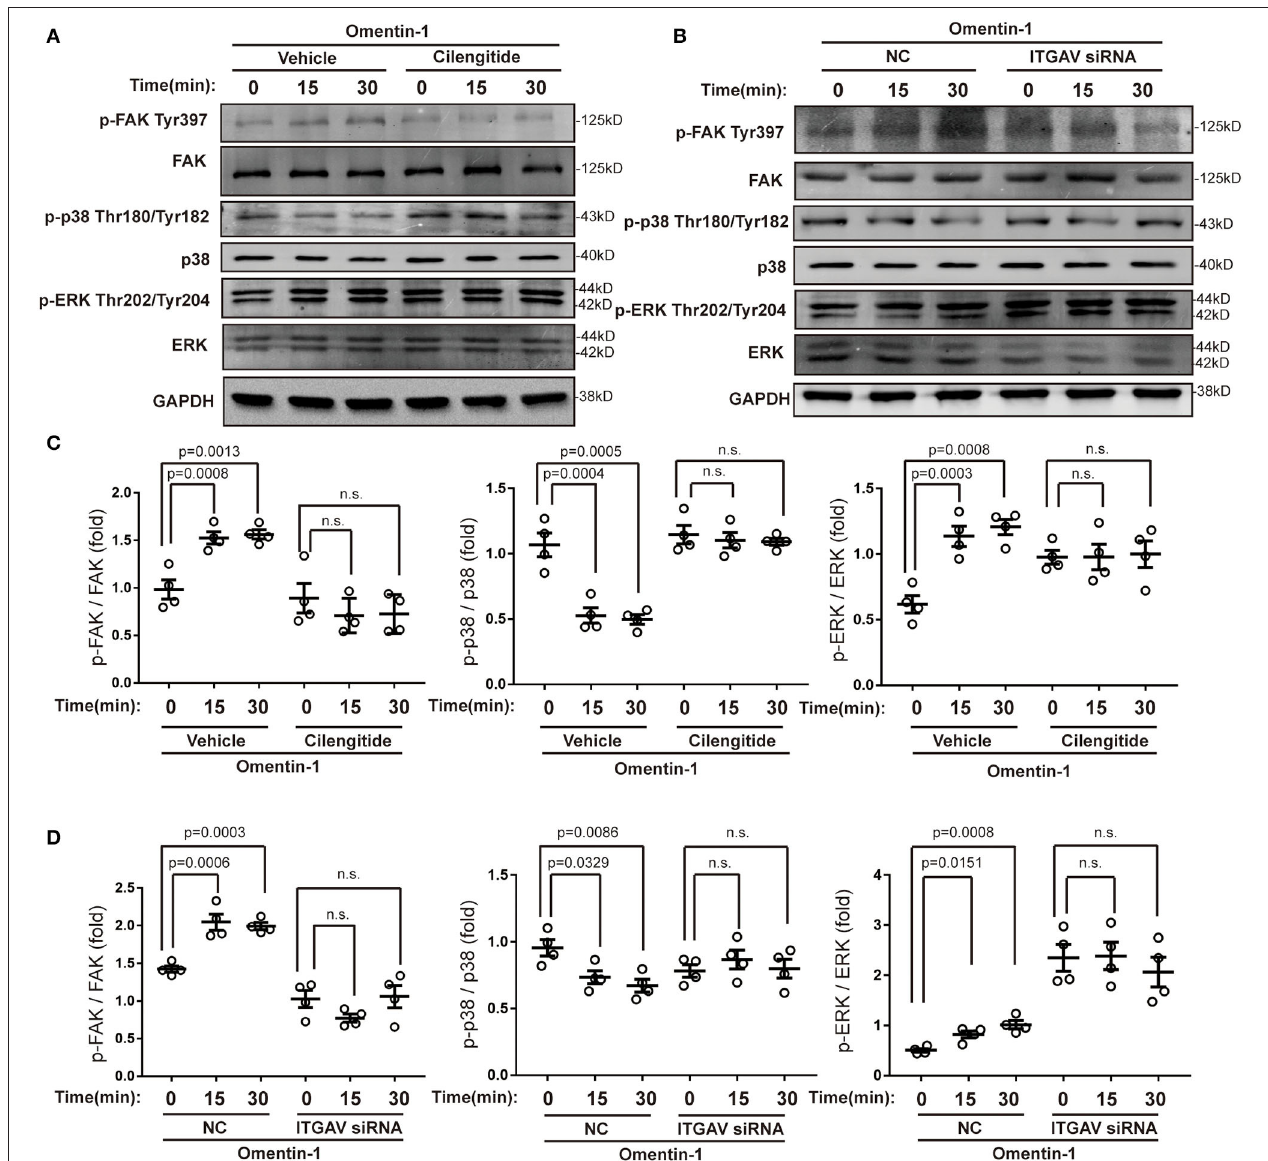
FIGURE 7 | Omentin-1 triggered signals of integrin receptor in macrophages. (A) The RAW264.7-derived macrophages were pretreated by vehicle or cilengitide (2.5 µ M) for 1h and were subsequently stimulated by omentin-1 (600ng/ml) for 0, 15, and 30min. After that, they were harvested for immunoblotting analysis. (B) The RAW264.7-derived macrophages were transfected by negative control (NC) small-interfering RNA (siRNA) or ITGAV siRNA. Then they were stimulated by omentin-1 (600ng/ml) for 0, 15, and 45min. After that, they were harvested for immunoblotting analysis. (C) The graphs showed that omentin-1 significantly promoted the phosphorylation of focal adhesion kinase (FAK) at Tyr397 and p38 mitogen-activated protein kinase (p38 MAPK) at Thr180/Tyr182, while it suppressed the phosphorylation of the extracellular-regulated protein kinase (ERK) at Thr202/Tyr204 concomitantly. The adding of cilengitide abrogated the influence induced by omentin-1 in the RAW264.7-derived macrophage ( n = 4). (D) The graphs showed that omentin-1 significantly promoted the phosphorylation of FAK at Tyr397, p38 MAPK at Thr180/Tyr182, and suppressed the phosphorylation of ERK at Thr202/Tyr204 in the RAW264.7-derived macrophage transfected by NC siRNA. After being transfected by ITGAV siRNA, the influence induced by omentin-1 was abrogated ( n = 4). All the data in this figure were presented as mean ± SEM (n.s.,